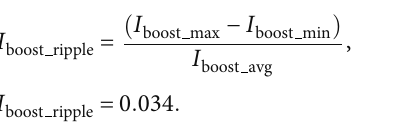
Table 7: Parameters of the PV system-based DC microgrid operated with half-bridge BDC in boost